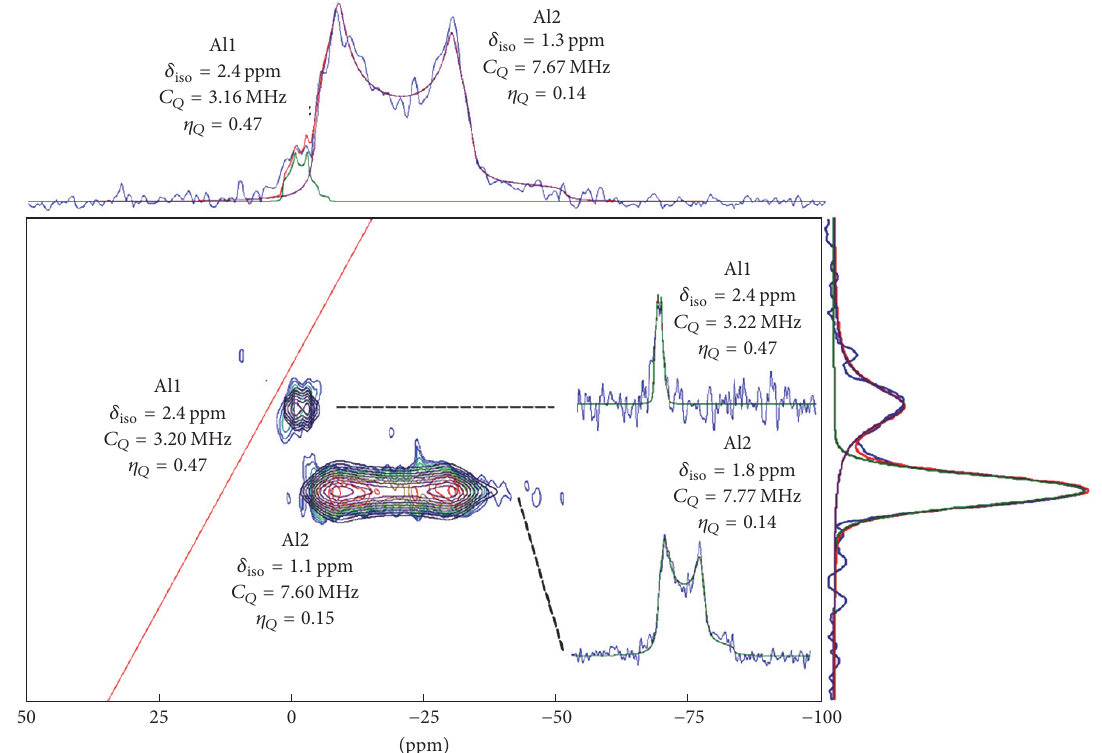
Figure 3: Contour plots of 27 Al 3QMAS NMR of MIL-118A. Reprinted with permission from Ref. [20]. Copyright 2009 American Chemical